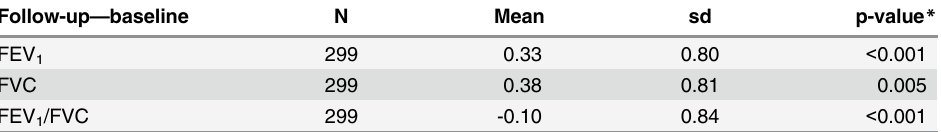
* : Two one-sided tests (TOST) for equivalence were performed to test on equivalence between the mean deviations in z-scores of the GLI reference population and SALIA. A good longitudinal fi t was reached if the null-hypothesis of the mean deviations in z-scores outside of the interval [-0.5, 0.5] was rejected at the